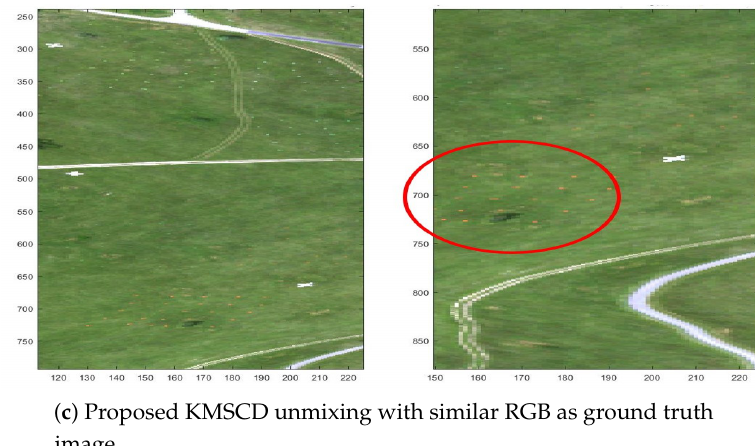
( c ) Proposed KMSCD unmixing with similar RGB as ground truth image. Figure 7. RGB image of the Selene Dual data set to show the location of the trace target materials and the ability of DL algorithms to recover them.